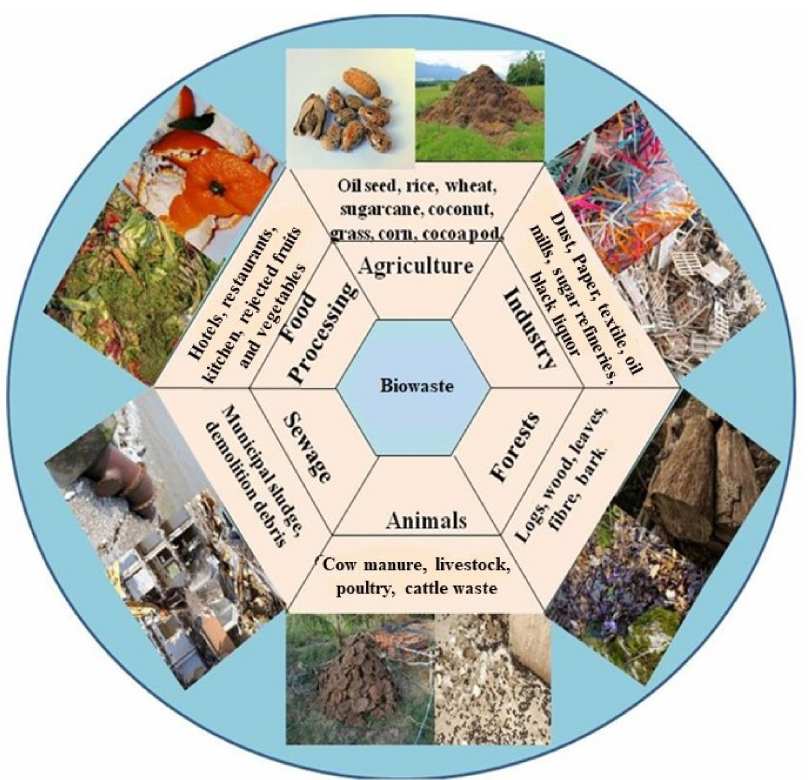
Figure 2. Classifications of biowaste in various sectors, i.e., food processing, agriculture, industry, forests, sewage, and